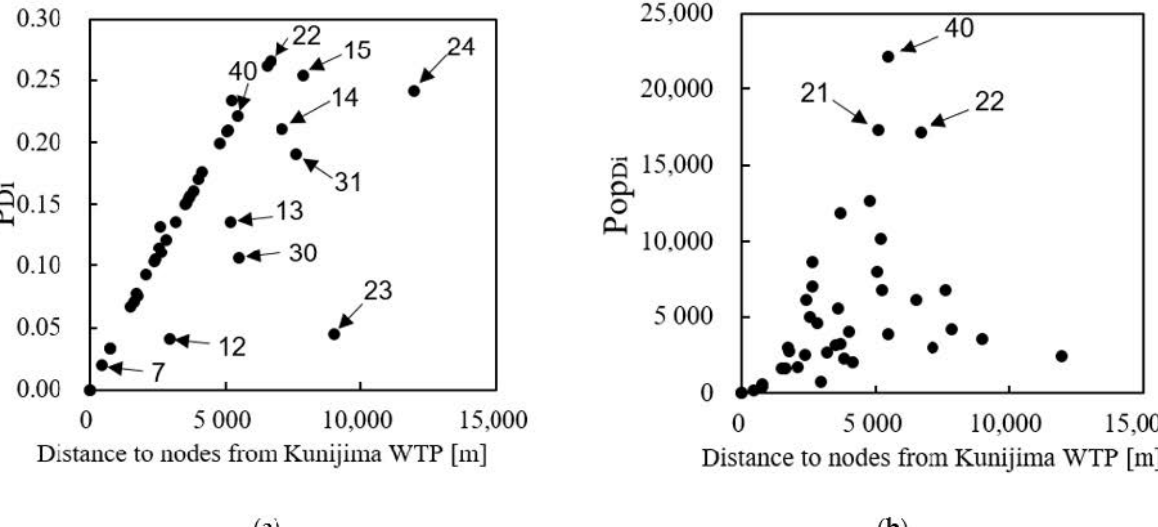
Figure 4. The relationship between the distance to nodes from Kunijima WTP and ( a ) water outage rate ( P D ) and ( b ) expected water outage population ( Pop D ) in the base case. The numbers in each graph correspond to those of nodes in Figure 3. The relationship of these three parameters is shown as a 3D graph in Figure S2 in Supplementary Materials.